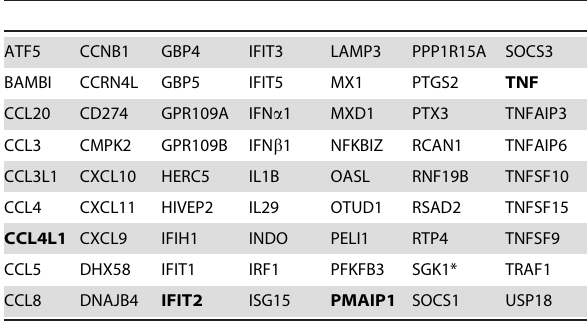
Table 4. Genes strongly up- or down-regulated in response to H5N1 infection versus H1N1